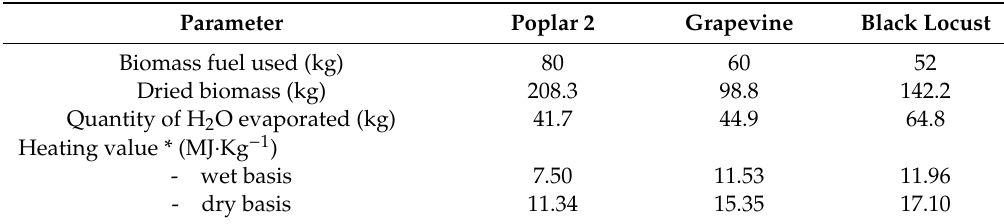
Table 5. Energy parameters (average data for each drying